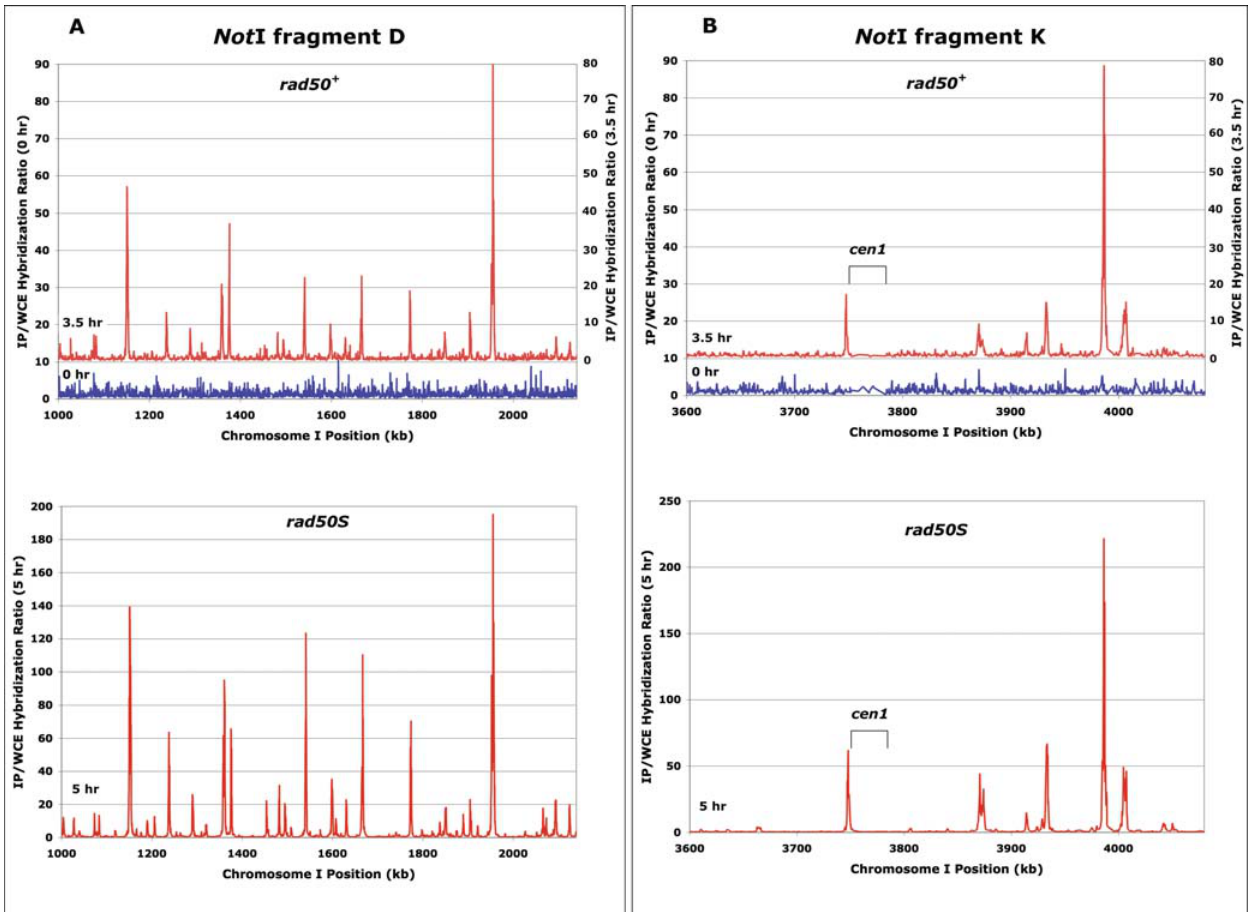
Figure 3. Microarray Analysis Reveals Indistinguishable DSB Hotspot Patterns in rad50 + and rad50S Strains. Line graphs represent the median-normalized Rec12 IP/WCE ratios from the (A) Not I D and (B) Not I K restriction fragments, which were examined by Southern blot analysis (Figure 1). Peaks of IP enrichment in the rad50 + (top, GP6232) and rad50S (bottom, GP6203) strains map to the same locations, with the rad50S strain showing, as expected, a higher level of enrichment due to accumulation of unrepaired DSBs. The data, from Dataset S2, are neither filtered for spurious values nor smoothed.